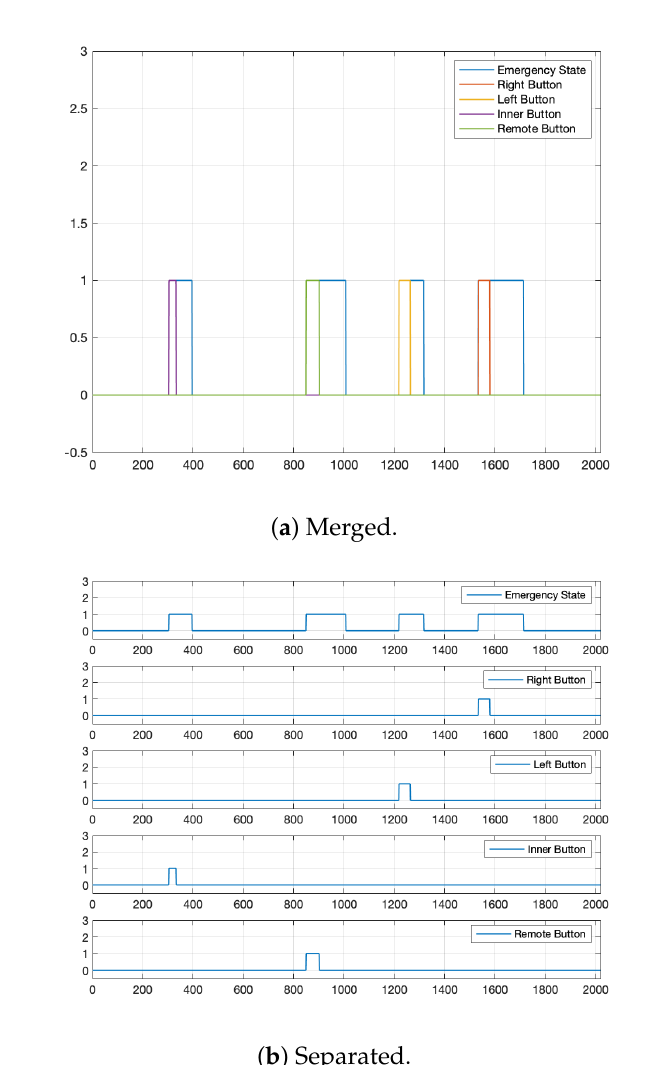
Figure 26. Response of emergency